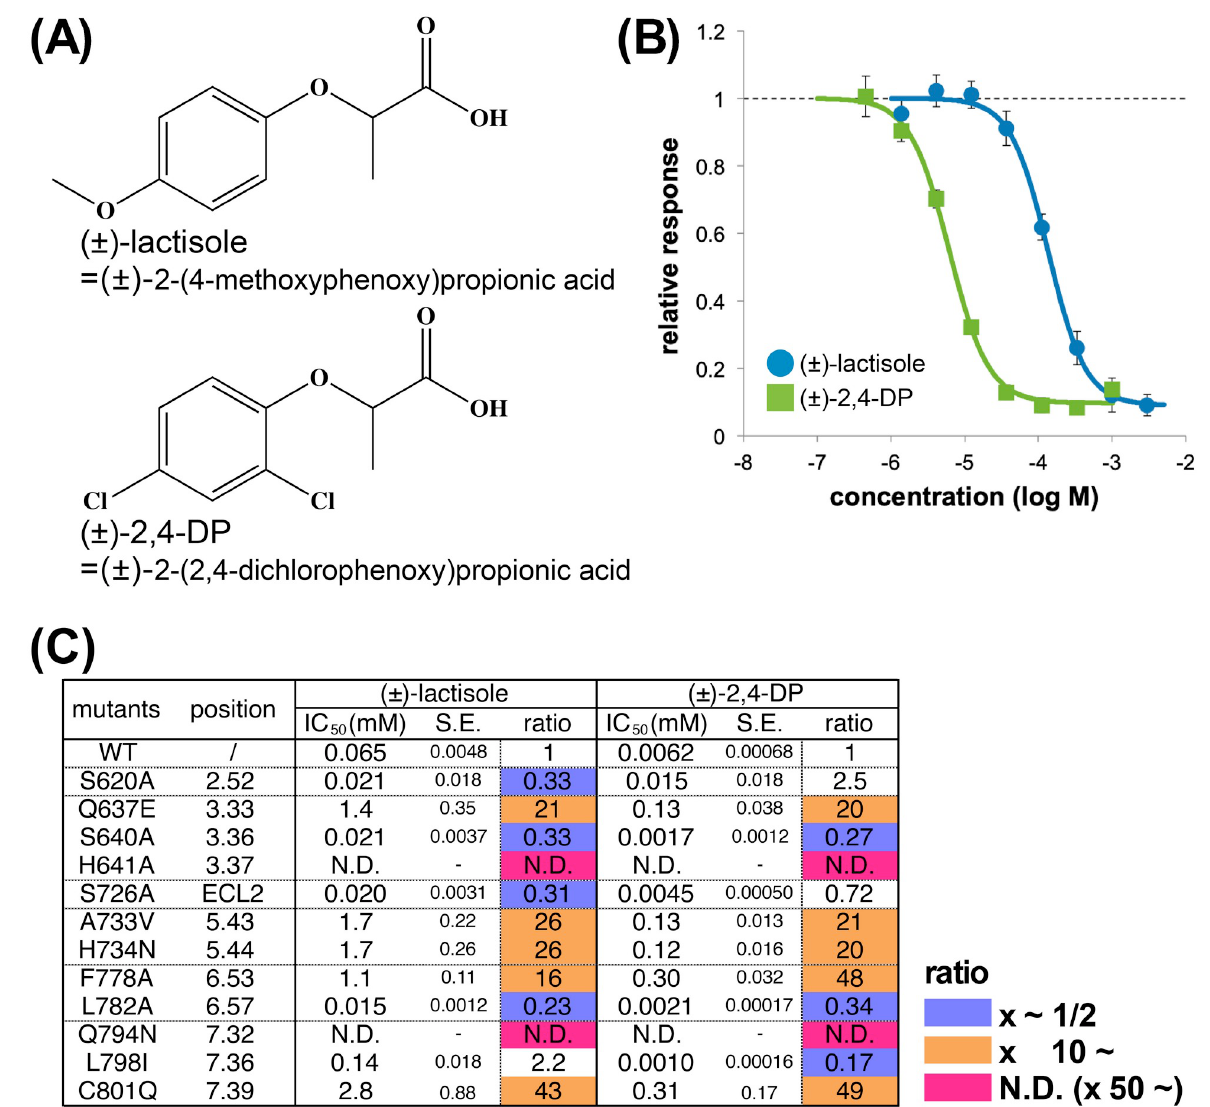
Fig 1. Lactisole and 2,4-DP as sweet taste inhibitors. (A) Structural formulas of ( ± )-lactisole and ( ± )-2,4-DP. (B) Dose-response curve showing the inhibition of the cellular responses of cells stably expressing the WT sweet taste receptor by ( ± )-lactisole and ( ± )-2,4-DP. Each inhibitor was added to 1 mM aspartame. The results for ( ± )-lactisole are shown in blue, and those for ( ± )-2,4-DP are shown in green. Data are shown as the mean ± SEM (n = 4). (C) Summary of mutational analysis for inhibitors (S.E.: standard error of each IC 50 ). The results are summarized in S1 Table. Each ratio was calculated by dividing the value for the mutant by that for the WT. Mutants with IC 50 ratios < 1/2 are colored in blue, � 10 in orange, and � 50 or N.D. in magenta, respectively. N.D., not determined since inhibitory activity was almost entirely eliminated.